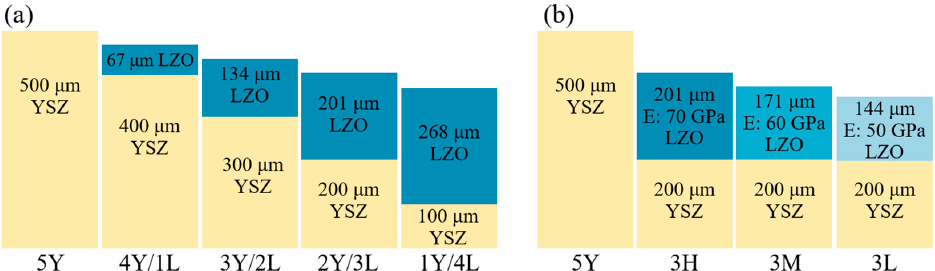
Figure 41. Schematic diagram of DCL structure: ( a ) equivalent thermal insulation with different thickness ratio ( b ) equivalent thermal insulation with different modulus [217,218] .